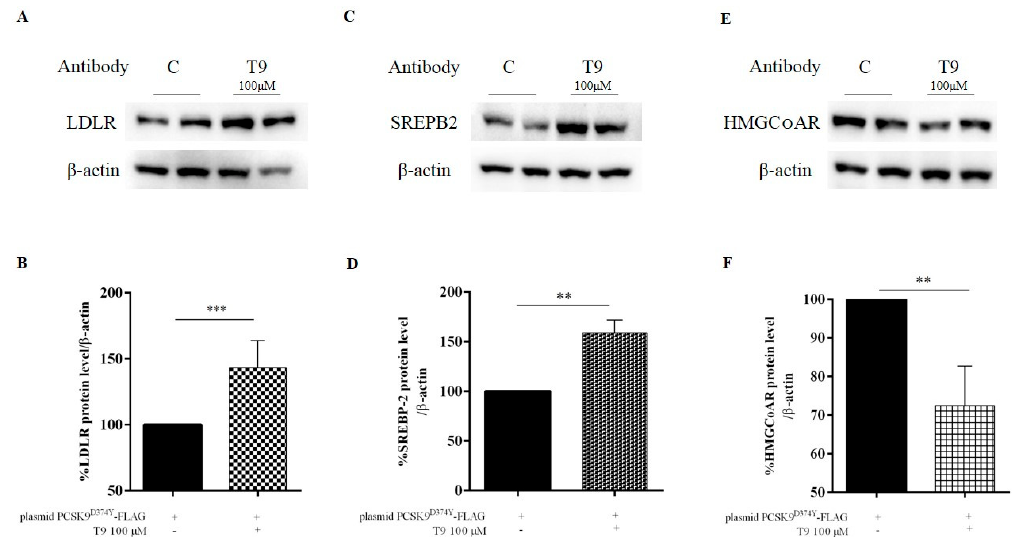
Figure 3. Effects of T9 on LDLR ( A,B ), SREBP-2 ( C,D ), and HMGCoAR ( E,F ) protein levels. Transfected HepG2 cells were incubated with T9 for 24 h. LDLR, SREBP-2, HMGCoAR, and β -actin were detected by immunoblotting using anti-LDLR, anti-SREBP-2, anti-HMGCoAR, and anti- β -actin primary antibodies, respectively. Bars represent averages ± S.D. of four independent experiments (two duplicates per sample). (**) p < 0.001, (***) p < 0.0001 vs. untreated transfected samples (C: control cells).